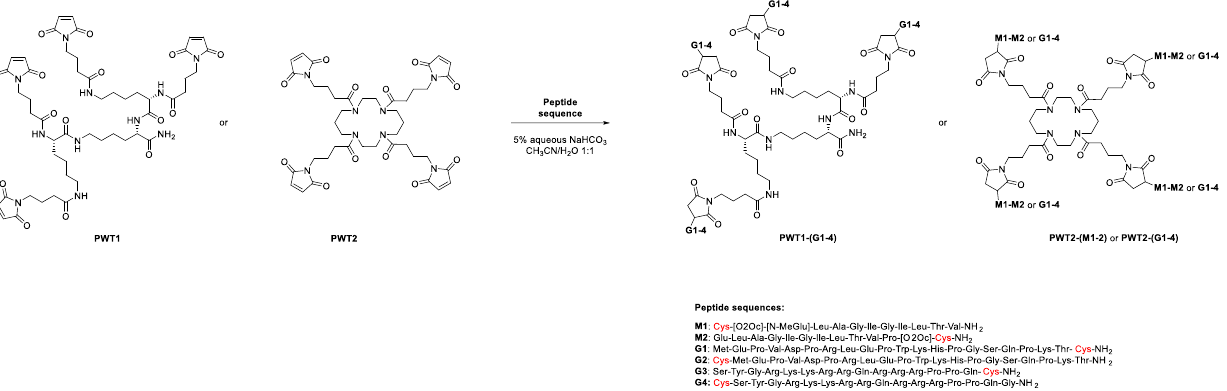
Figure 1. Tetrafunctionalization of PWT1 and PWT2 with the peptide sequences M1–2 and